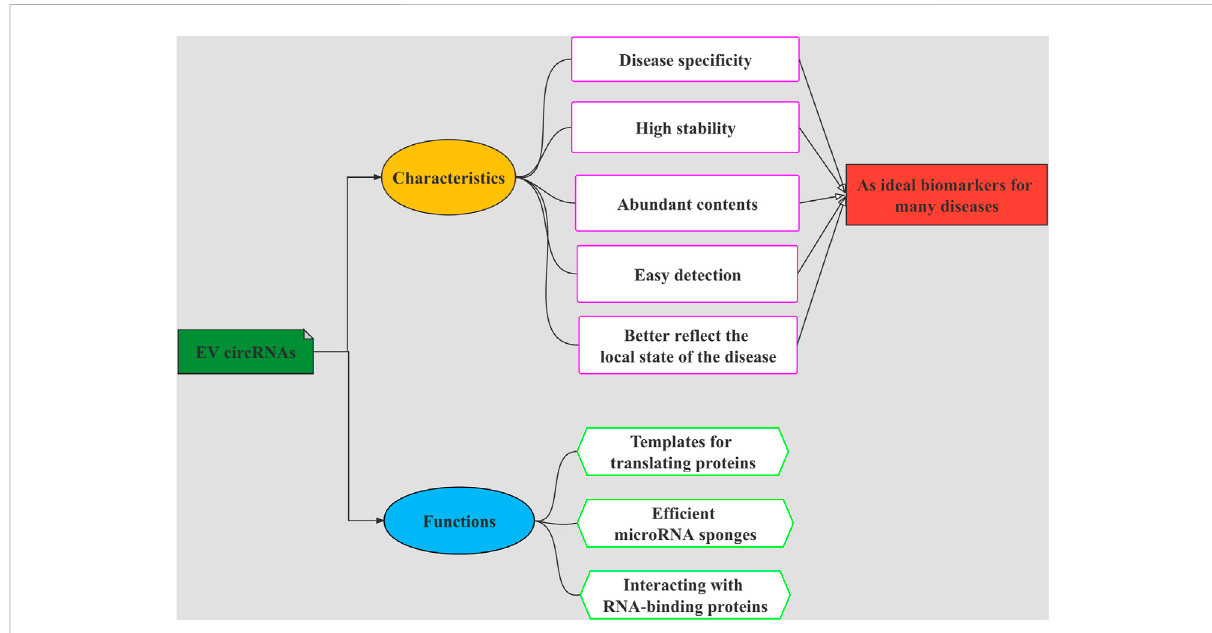
FIGURE 2 The overview diagram shows multiple characteristics and biological functions of EVs-circRNAs. The functions of EV circRNAs are as templates for translating proteins, ef fi cient microRNA sponges, and interacting with RNA-binding proteins. EV circRNAs have such characteristics, as disease speci fi city, high stability, abundant contents, and easy to be detected. These functions and characteristics make them to be used as promising candidate biomarkers for many